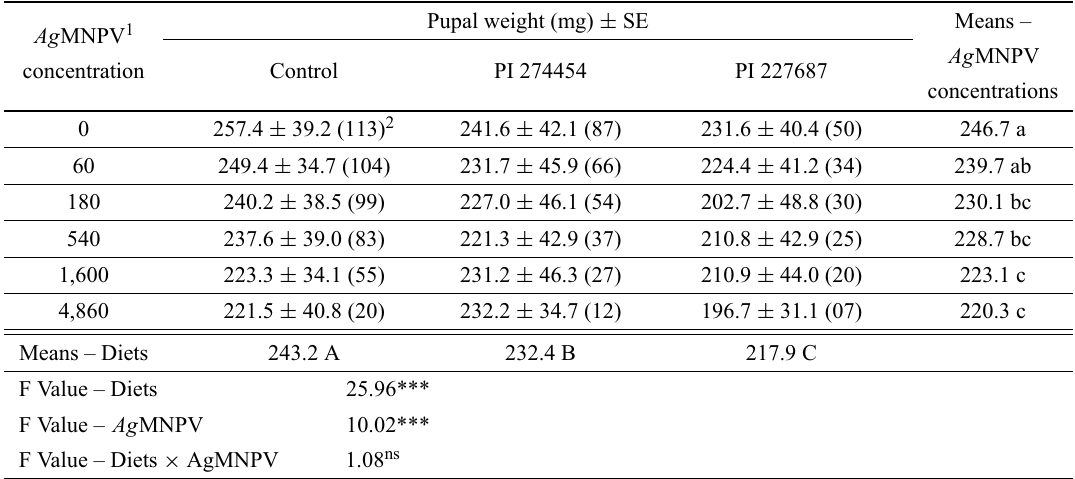
Pupal weights of Anticarsia gemmatalis (S population) fed on diets containing soybean extracts (PI 274454 and PI 227687) and different AgMNPV concentrations, with the number of surviving individuals in